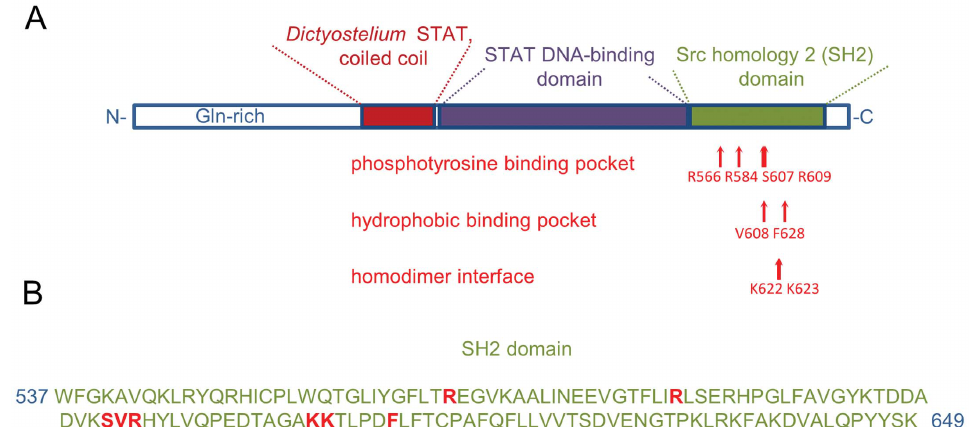
Figure 1. A.castellanii STAT protein domains. ( A ) The overview of the protein domains. The residues that form phosphotyrosine binding pocket, hydrophobic binding pocket and homodimer binding interface are indicated with arrows. ( B ) The SH2 domain sequence. The residues that form the phosphotyrosine binding pocket, hydrophobic binding pocket and homodimer binding interface are in red color.